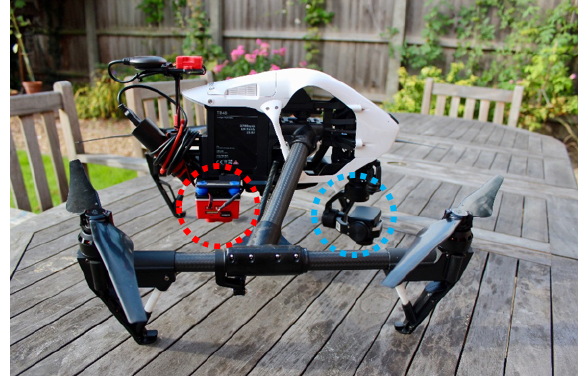
Figure 1. UAV system for data collection [9].